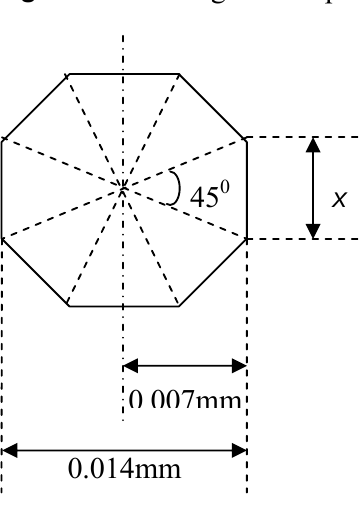
Figure 4. An octagonal shaped cell.